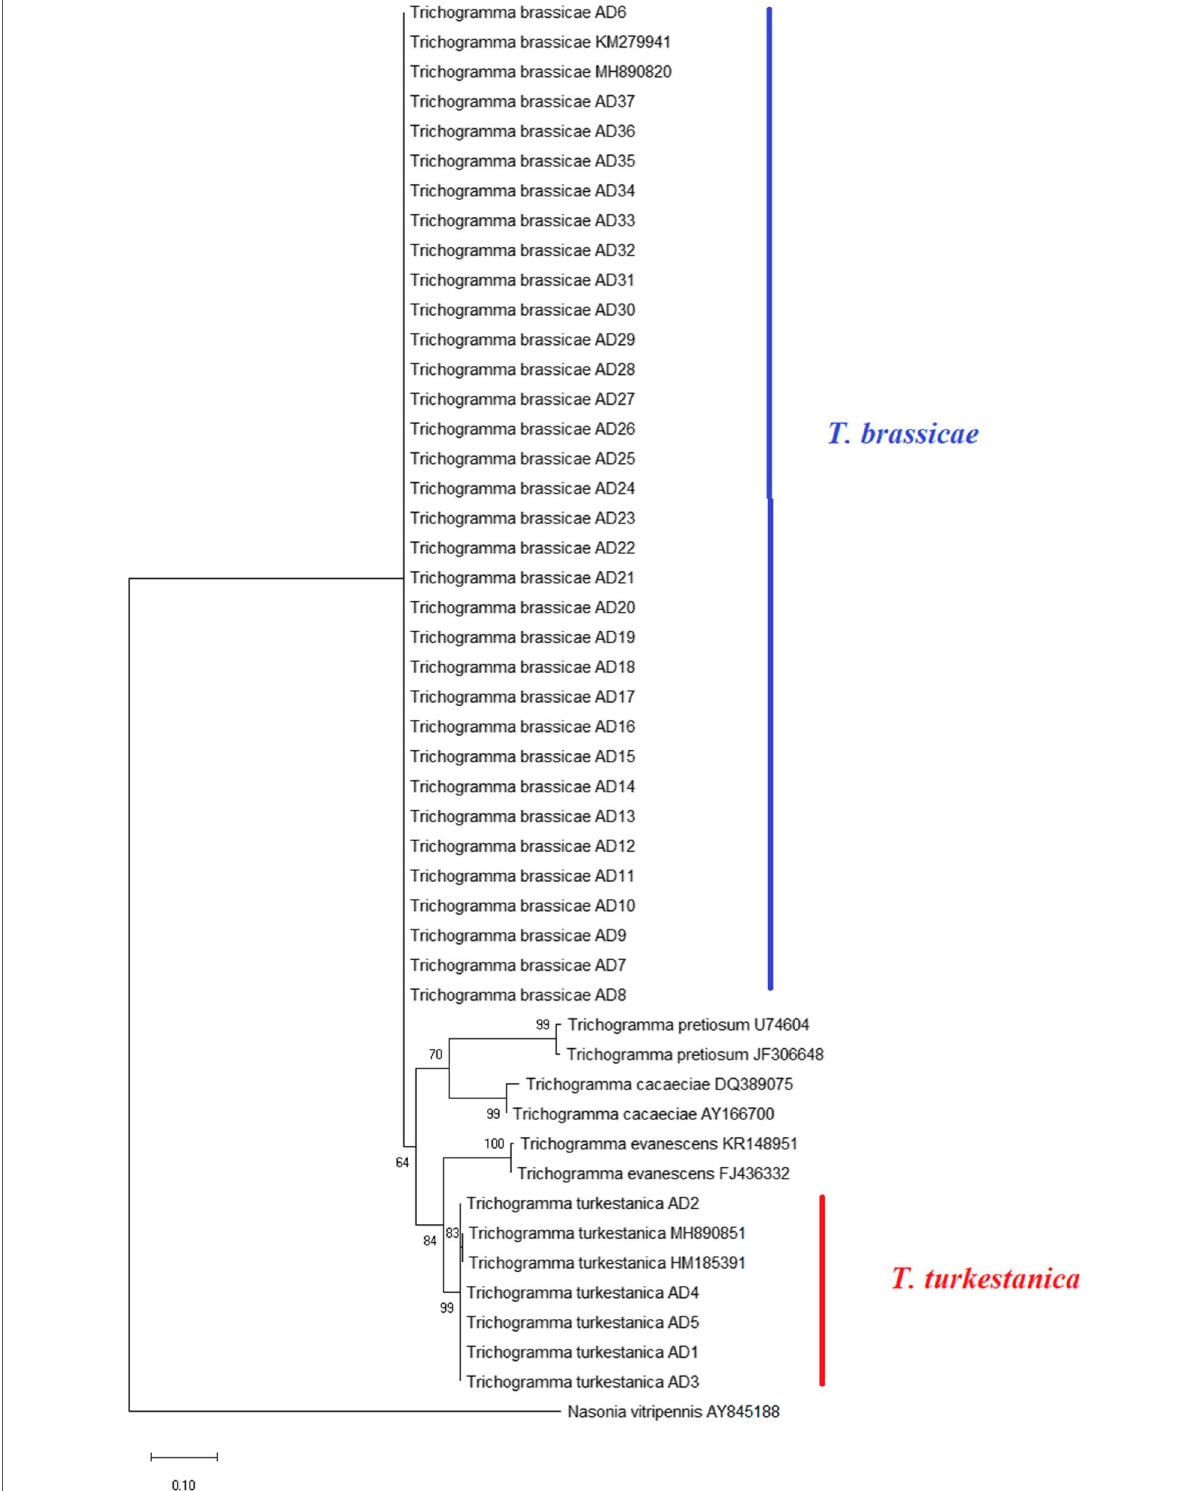
Fig. 2 Phylogenetic tree based on ITS2 gene region of Trichogramma specimens was constructed by using the Maximum Likelihood method based on the Kimura 2-parameter model with a discrete Gamma distribution to model evolutionary rate differences among sites. Numbers on the branches indicate the bootstrap values of